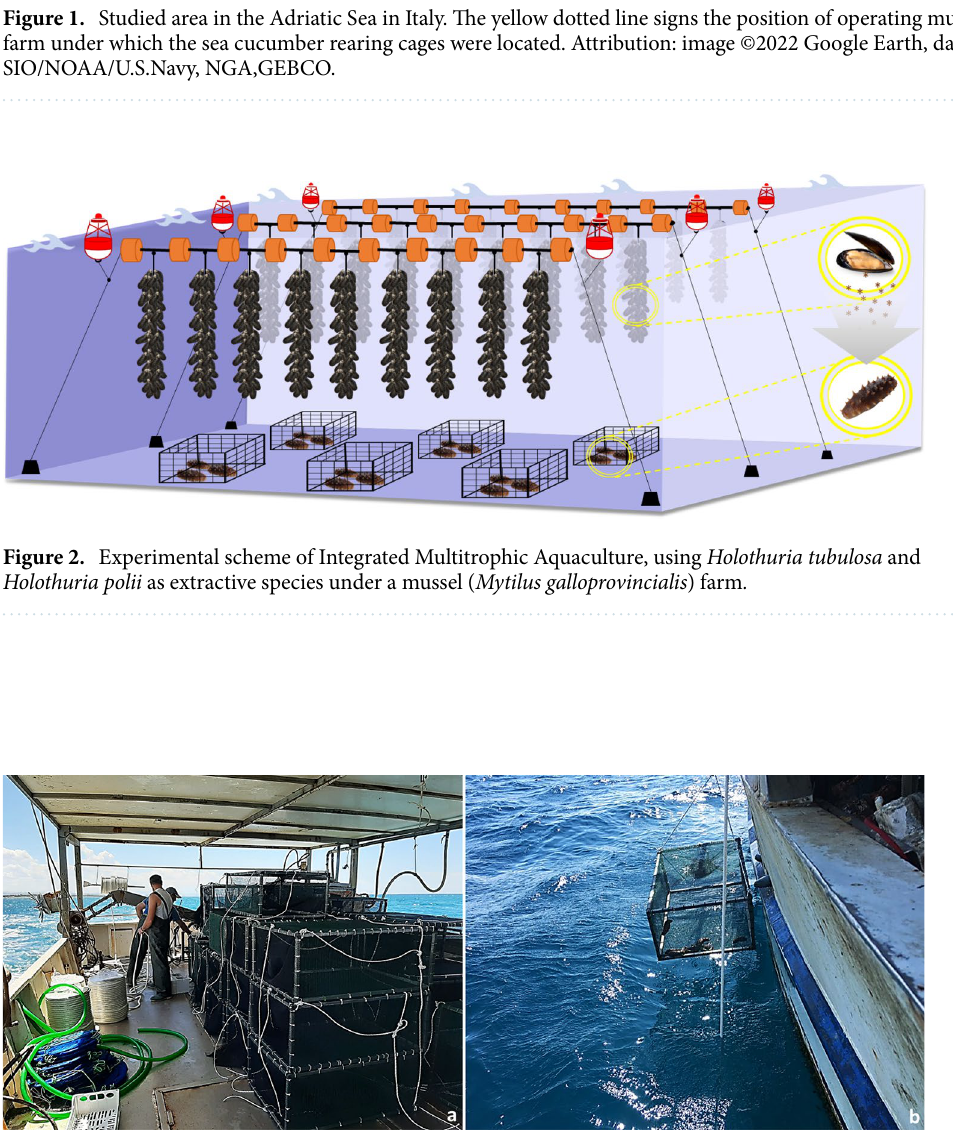
Figure 3. Sea cucumber experimental cages ( a ) and cage deployment ( b